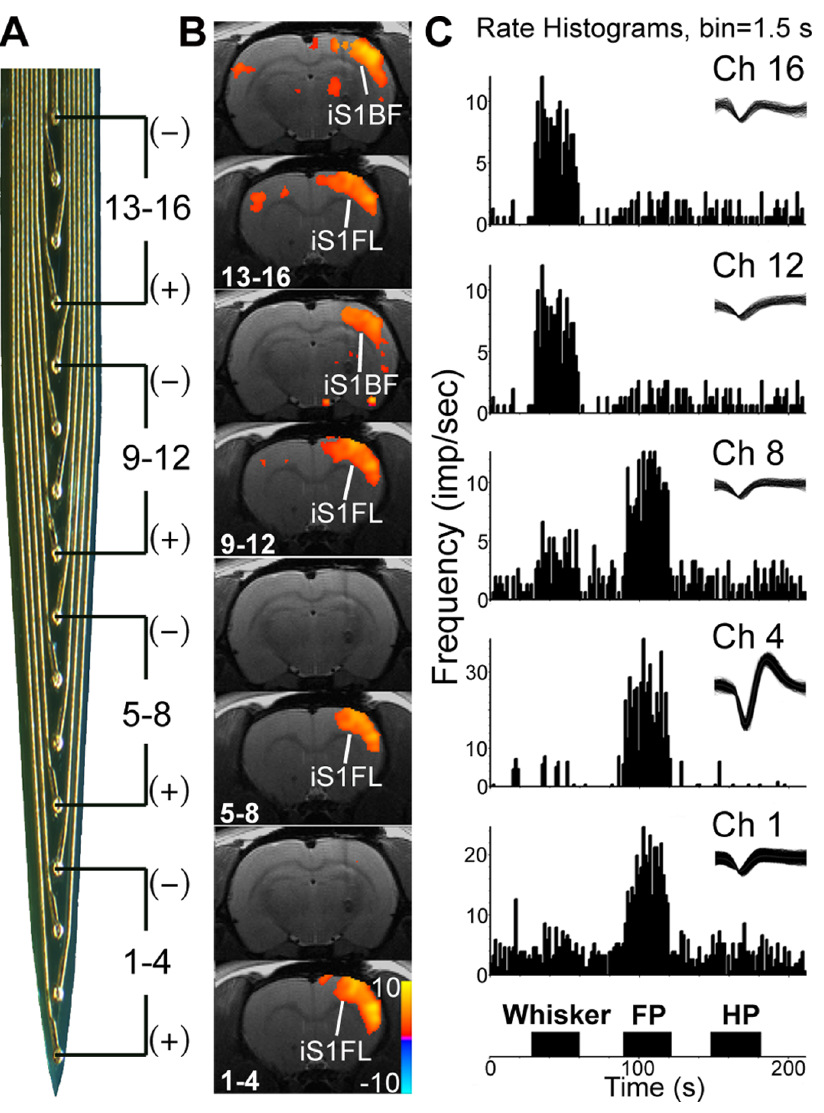
Figure 2. VP stimulation evoked BOLD activation maps that relate to sensory representation. (A) The four electrode-pad pairs that were used for bipolar constant current stimulation (3 Hz, 200 m A) are diagrammatically shown on the photomicrograph of the linear 16-channel stimulation electrode. (B) BOLD activation maps. Two BOLD maps, one related to the rostral iS1BF and the other caudal iS1FL levels, are shown for each of the four electrode pairs. (C) Neural responses in the VP recording by the microelectrode array. Air-puff stimulation was used on rat including forepaw (FP), hind-paw (HP) and whisker.